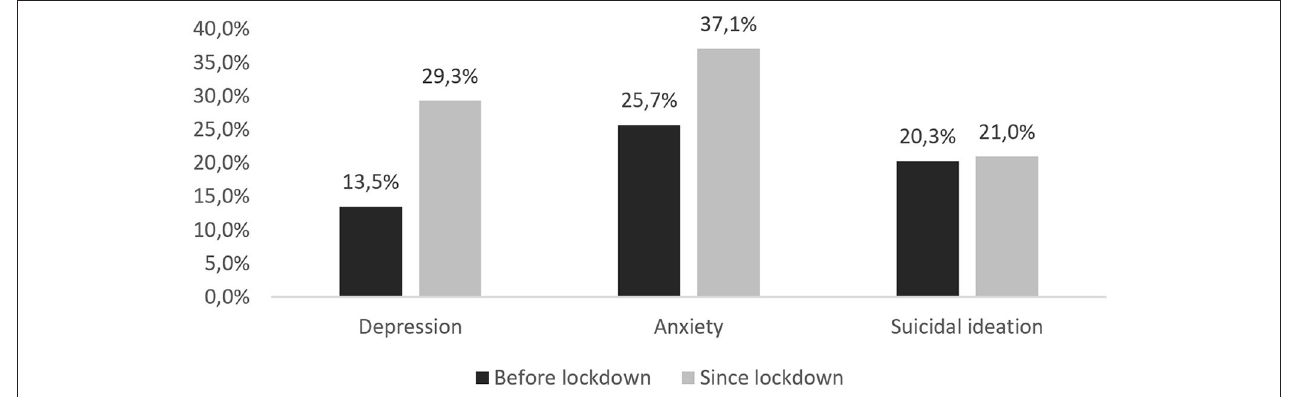
FIGURE 2 | Proportions of participants screening positive for depression, anxiety and suicidal ideation before and since lockdown ( N =